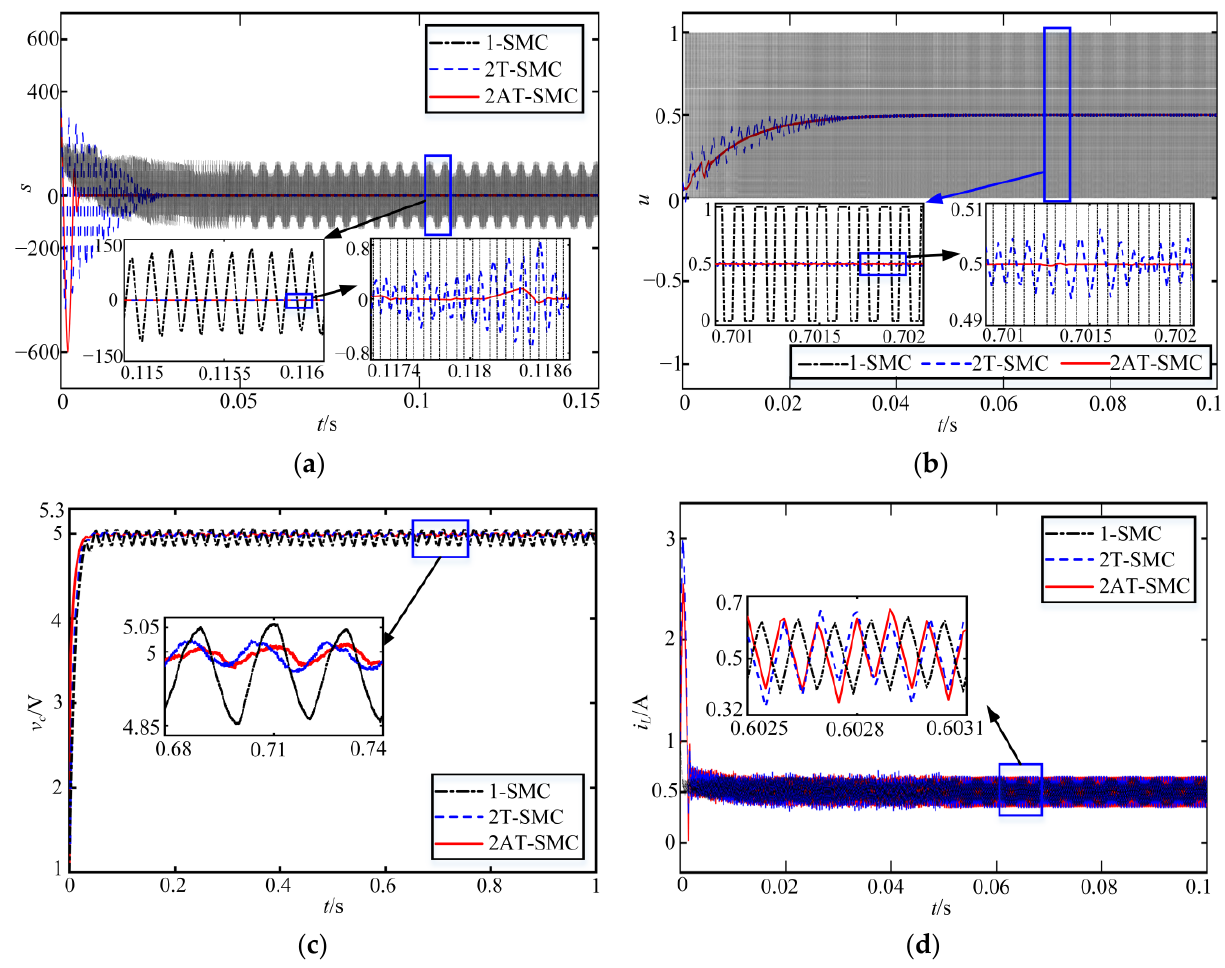
Figure 7. Comparative simulations in disturbing condition: ( a ) Sliding variable s ; ( b ) Control law u ; ( c ) Output voltage v c ; ( d ) Inductor current i L . Table 3. Defined the possible disturbances in the buck converter system. Table 4. Comparison of voltage and current in multi-disturbed working